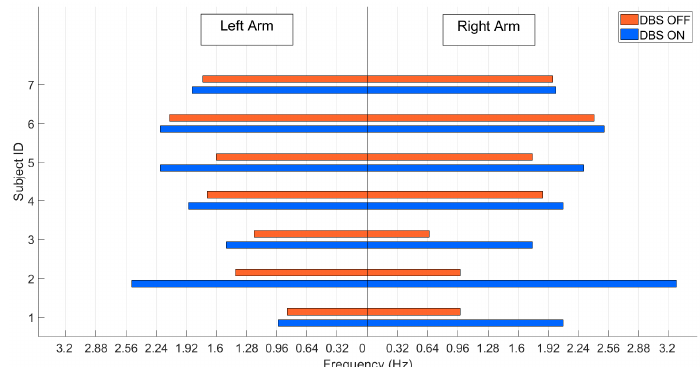
Figure 11. Comparison of supination and pronation frequency.